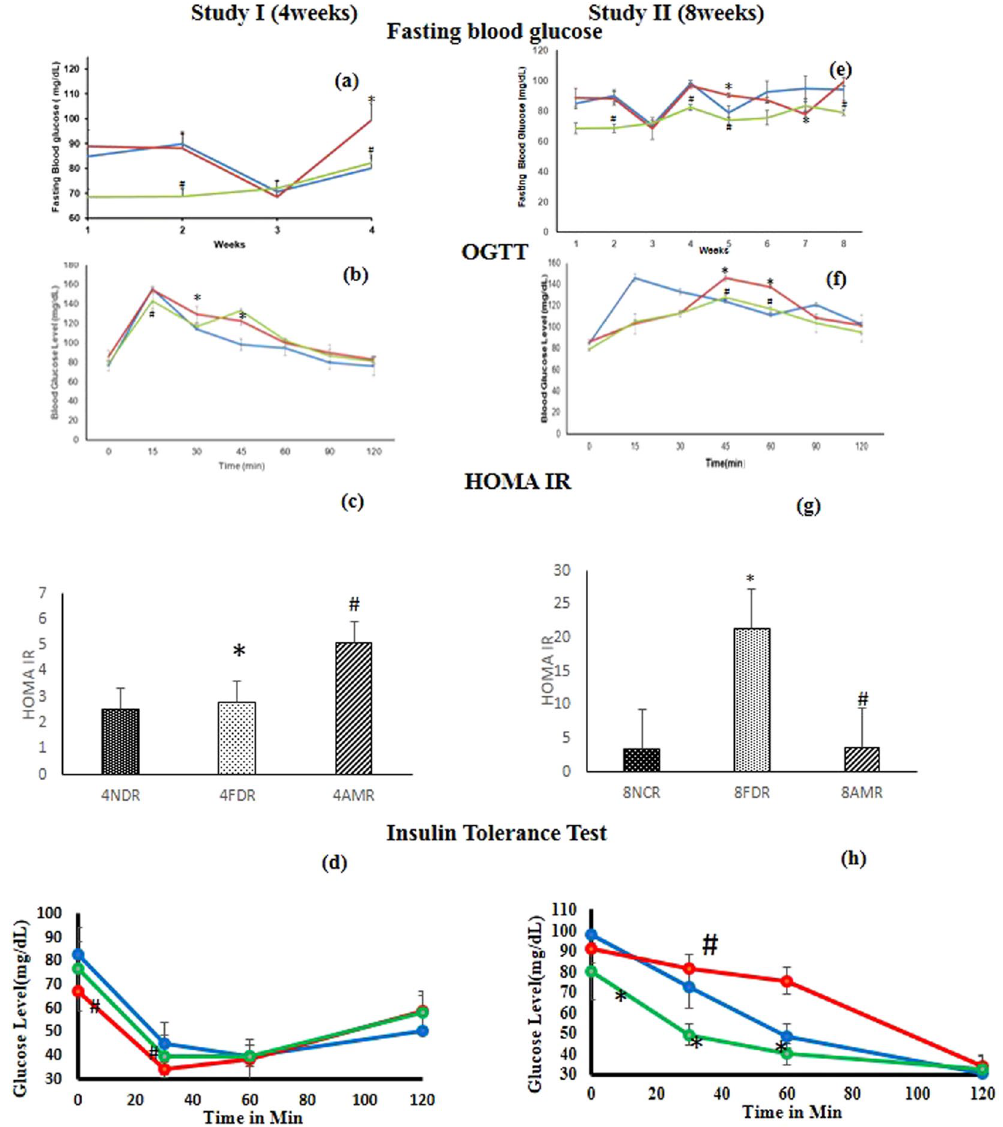
Figure 3. Comparison of weekly fasting blood glucose levels (FBG), presentation of oral glucose tolerance test (OGTT), homeostatic model assessment-insulin resistant (HOMA-IR) and insulin tolerance test (ITT) after 4 weeks(study I) and 8 weeks (study II) of fructose ingestion. The FBG, OGTT, HOMA-IR, ITT at developing ( a–d ) and adulthood ( e–h ) stages in normal (blue line), fructose-control (red line) and AM-HM (green line) treated groups are represented. The FBG was lowest in 4AMR and 8AMR. In studies I and II, the AUC-OGTT was highest in FDR as compared to NDR. HOMA-IR, an indicator of feedback loop between the liver and the β -cell, was significantly elevated in 4FDR and 4AMR, as compared to 4NDR and 4FDR, respectively. In study II, the significantly raised HOMA-IR value in 8FDR as compared to 8NDR was reverted in 8AMR. In ITT, the simulated hypoglycemic response in 4NDR, 4AMR was parallel. The hypoglycemia nadir in 4FDR was at the same time point as 4NDR, albeit significantly steeper, implying impairment of HPA axis. In study II, at adulthood, the animals in 8FDR recorded a delayed and attenuated response to insulin in terms of lowering blood glucose levels, evidencing an IR state, which was overcome in 8AMR. All values are mean ± SEM; (n = 6), * p < 0.05 vs NDR, # p < 0.001 vs